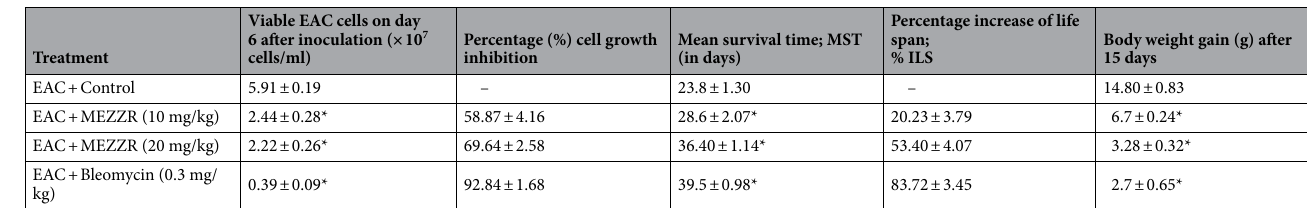
Table 3. Effect of MEZZR on cell growth inhibition, survival time and body weight gain of EAC cell-bearing Swiss albino mice. Data are expressed as mean ± SD for six animals in each group. Bleomycin is an anticancer drug. *P < 0.05: against EAC control group.